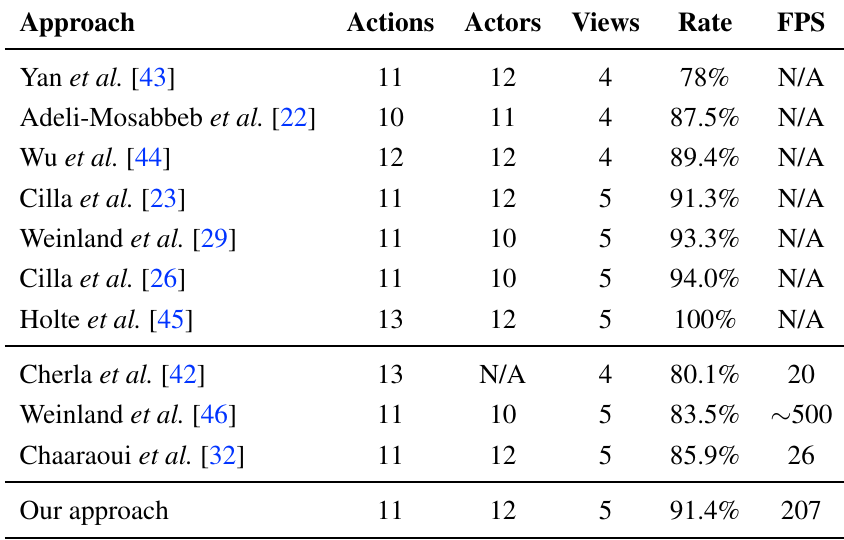
Table 6. Comparison with other multi-view human action recognition approaches of the state-of-the-art. The rates obtained in the LOAO cross-validation performed on the IXMAS dataset are shown (except for [42], where the type of test is not